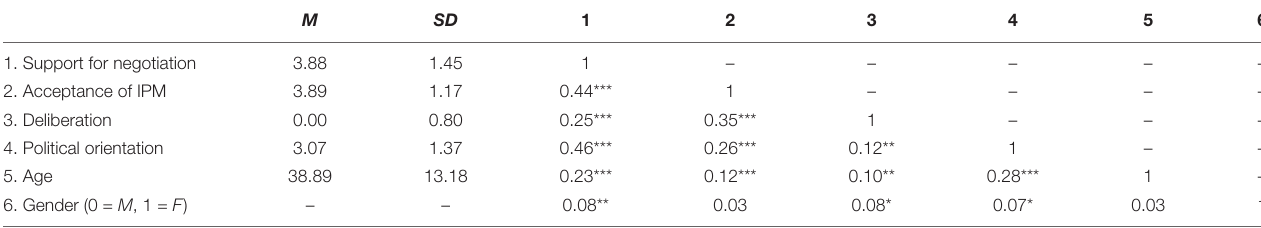
TABLE 5 | Descriptive statistics and bivariate inter-correlations (Study 3).